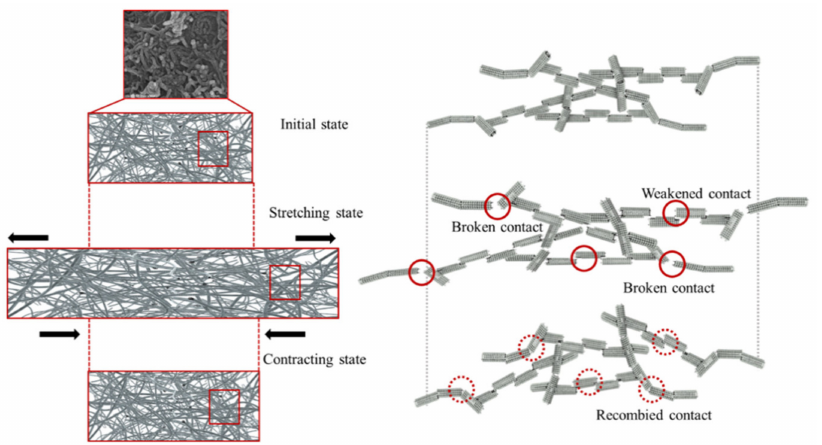
Figure 14. Schematic diagram of the changes in the contact state between the PTC-MWCNT particles during repeated stretching–contraction.